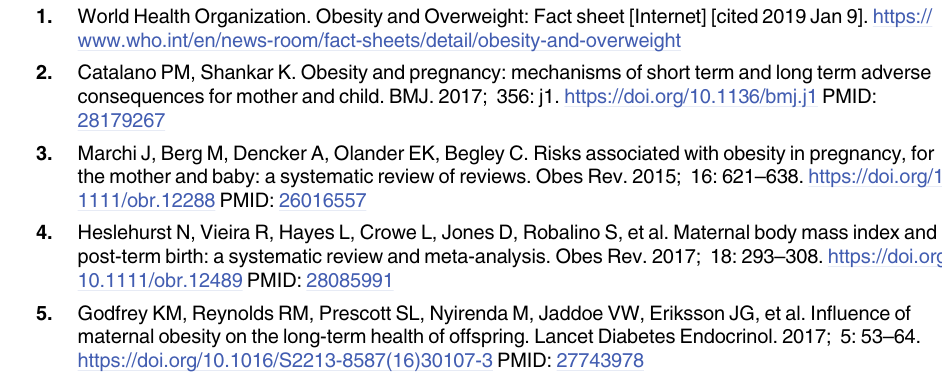
S6 Fig. Birth weight (grams) after bariatric surgery meta-analysis with subtotals by type of surgery. S7 Fig. Funnel plots of publication bias for perinatal outcomes after bariatric surgery. S8 Fig. Crude versus adjusted data for studies reporting adjusted odds